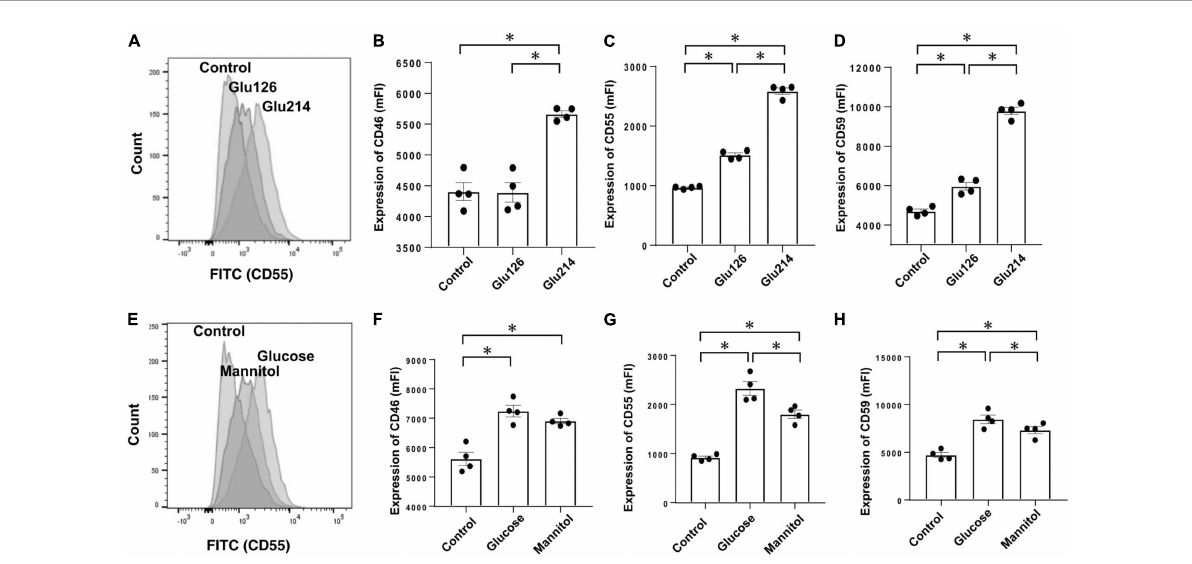
FIGURE5 Expressions of membrane complement regulators (CRegs) of Met-5A cells stimulated with glucose and evaluation of osmotic effects. Expressions of CRegs in Met-5A cells increased dependent on glucose concentration (A–D) . When the effects of osmolar stimulation were evaluated between 214 mOsm/L of glucose (equivalent glucose concentration to 2.5% glucose-based peritoneal dialysate) and the identical osmolality of mannitol, CD55 and CD59, but not CD46, were significantly increased with glucose, as compared to with mannitol. (A,E) Show sample histograms for CD55 expression stimulated with different concentrations of glucose-supplemented medium or control and stimulated with the same osmolality of glucose or mannitol, respectively. (B–D,F–H) Show changes in expressions of CD46, CD55, and CD59, respectively. Graph sets of panel (B–D,F–H) show results of stimulation with different concentrations of glucose and results of stimulation by glucose or mannitol at the same osmolality, respectively. ∗ P <